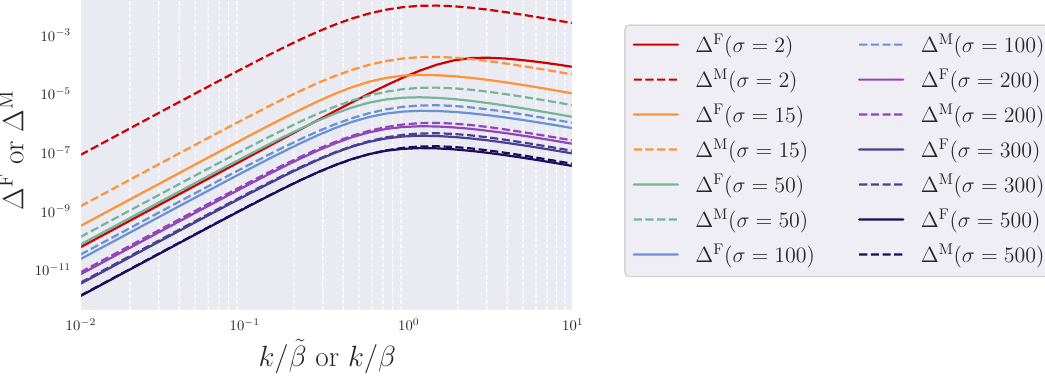
Figure 4 . Plot of GW spectrum. The solid curves indicate our results of ∆ F in FLRW spacetime, while the dashed curves indicates Jinno and Takimoto’s results of ∆ M in Minkowski spacetime. When σ = 2 ∼ O (1) , two curves deviate a lot. With increasing σ , two curves become more and more close. When σ & 200 , two curves almost coincide with each other as our expectation.